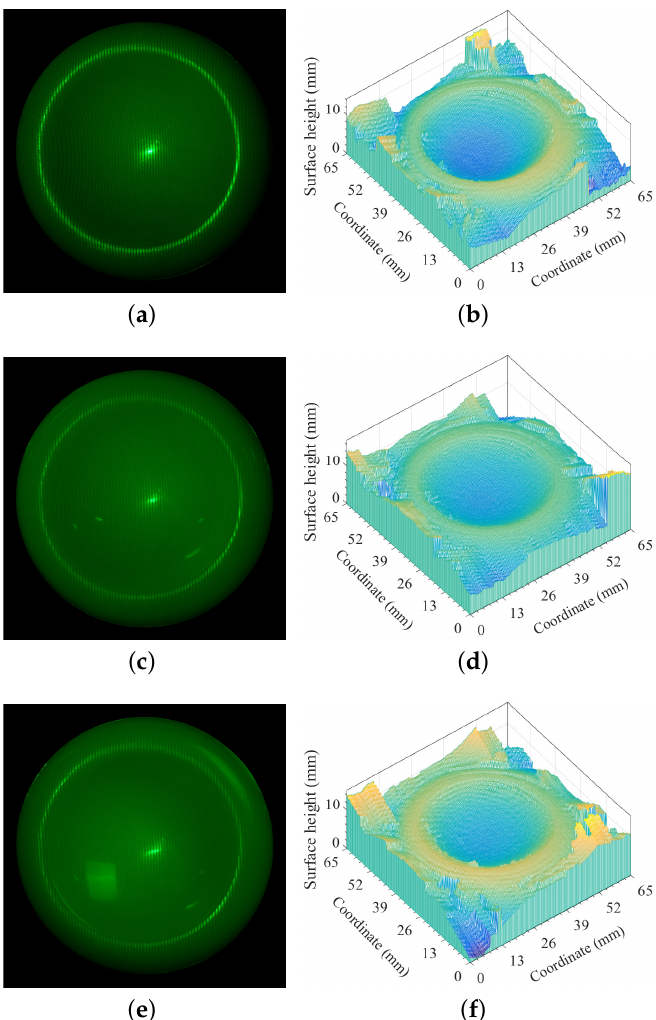
Figure 7. Measurement and reconstruction of the translucent plastic cap with different background illuminance E . ( a ) Measurement of E = 0. ( b ) Reconstruction using ( a ). ( c ) Measurement of E = 50 Lux. ( d ) Reconstruction using ( c ). ( e ) Measurement of E = 180 Lux. ( f ) Reconstruction using ( e